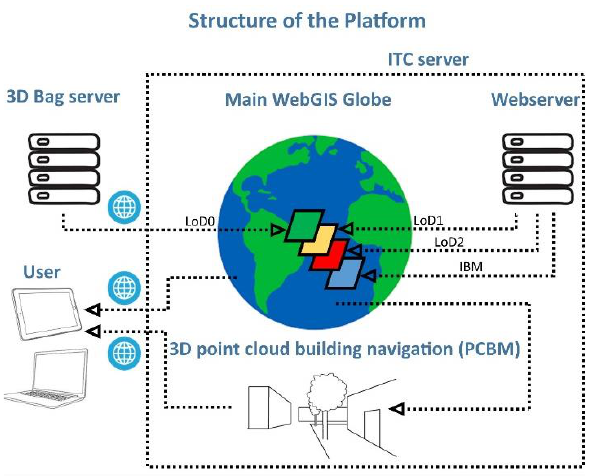
Figure 4 . Structure of the platform and the connections between the different parts that involve the system.